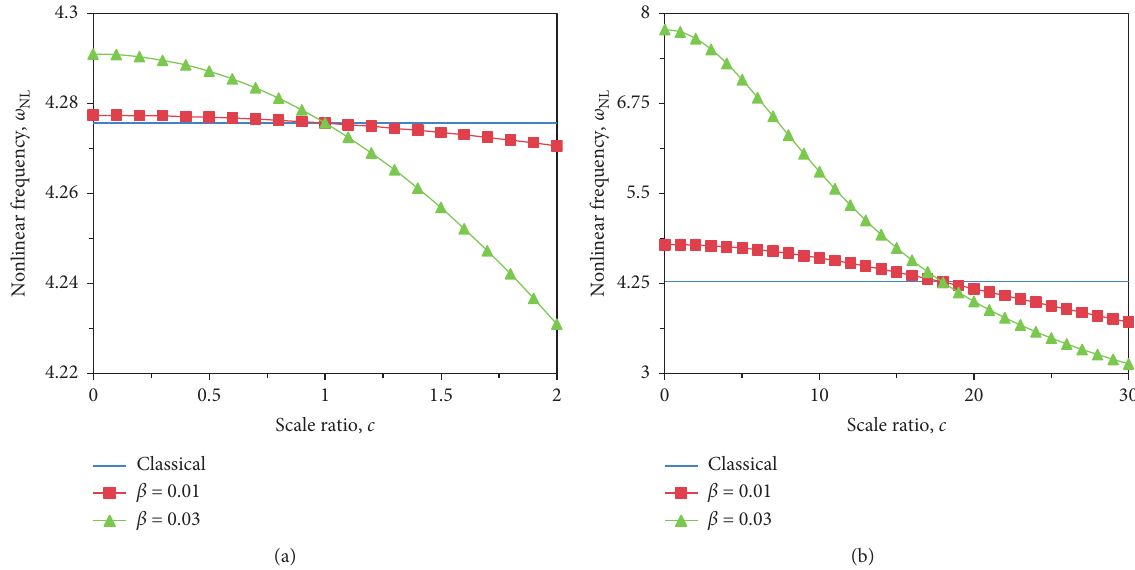
Figure 6: The variation of the nonlinear frequencies of the FG nanobeams to the scale ratio for k � 2, L / h � 15, and V thickness effect; (b) with thickness